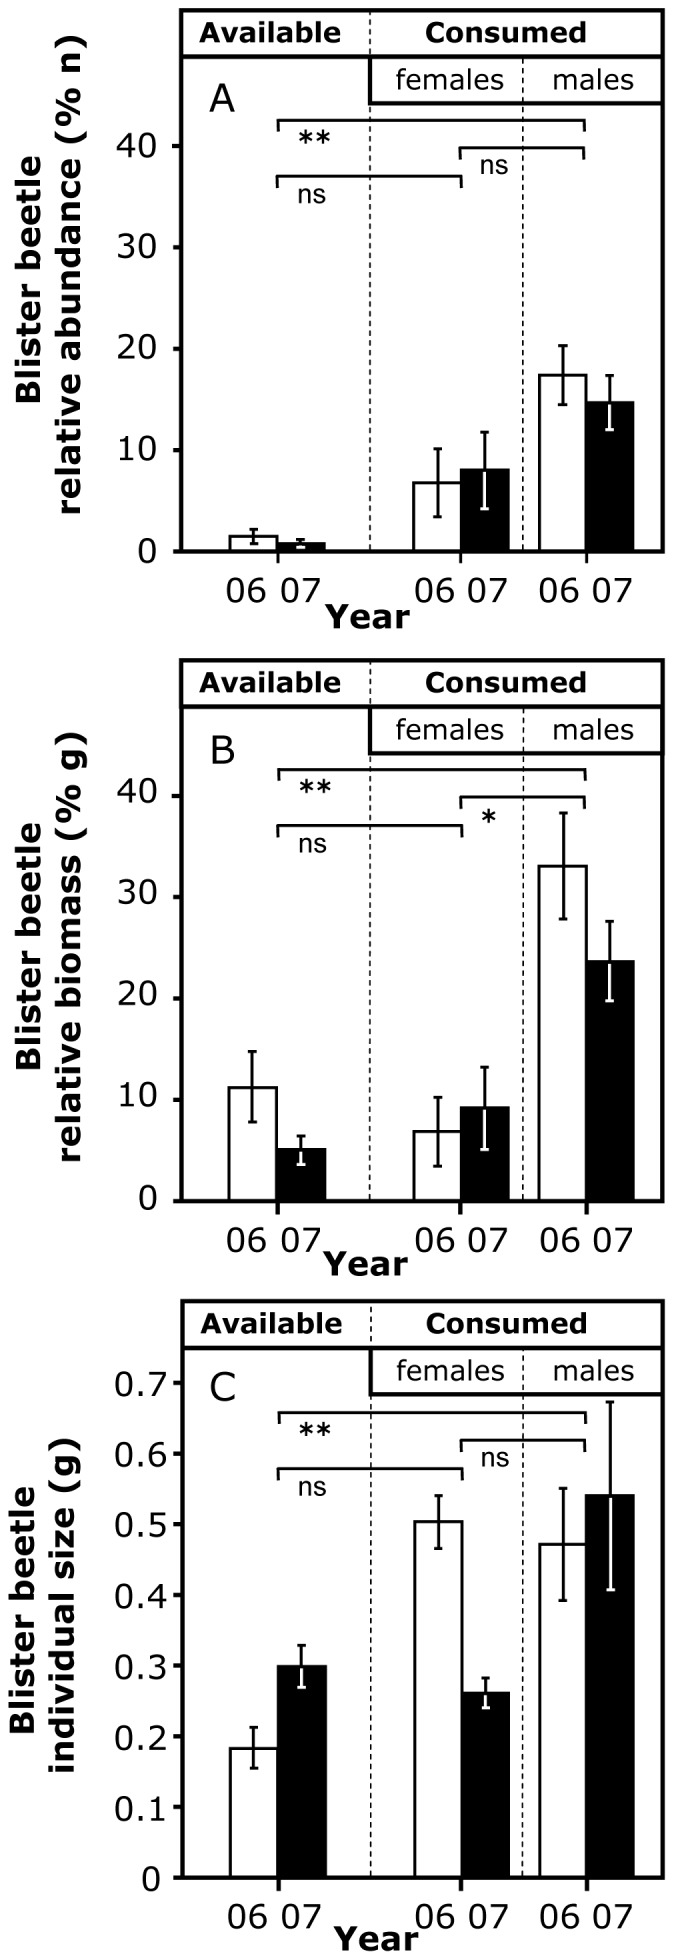
Blister beetle relative abundance (A) and biomass (B) in relation to all invertebrates sampled in field transects (column ‘available’), and found in faeces of females and males (columns ‘consumed’) in two springs (2006 and 2007).(C) Mean body size (± SD, g) of blister beetles sampled in field transects (column ‘available’) and found in faeces of females and males (columns ‘consumed’) in two springs (2006 and 2007). Differences in A and B were compared with the test of differences between percentages, and those in C with a Student's t-test, in all cases with data from both years pooled (horizontal lines; ns: P>0.05, *: P<0.05, **: P<0.01).